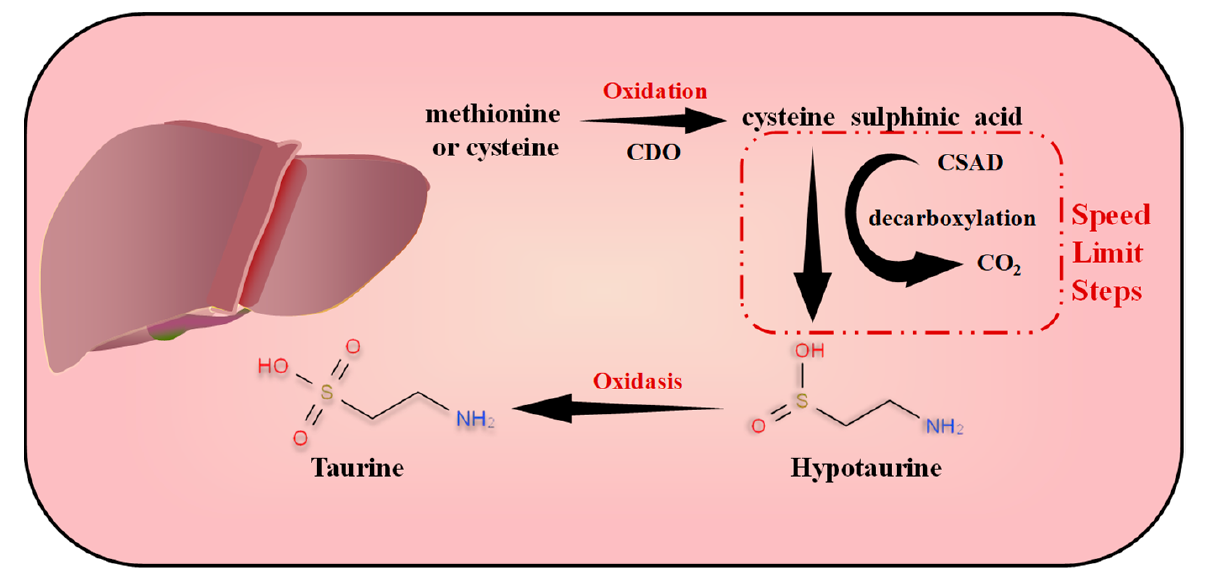
Figure 1. Taurine synthesis pathway in the liver. CDO = cysteine dioxygenase; CSAD = cysteine sulfinic acid decarboxylase.